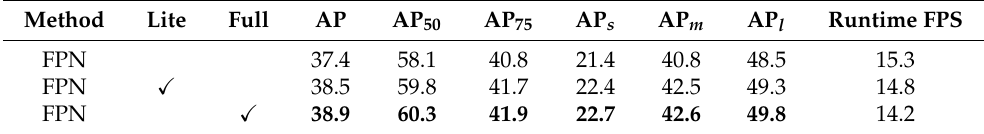
Table 4. Comparisons with lite version of our GCDN on MS-COCO 2017 val